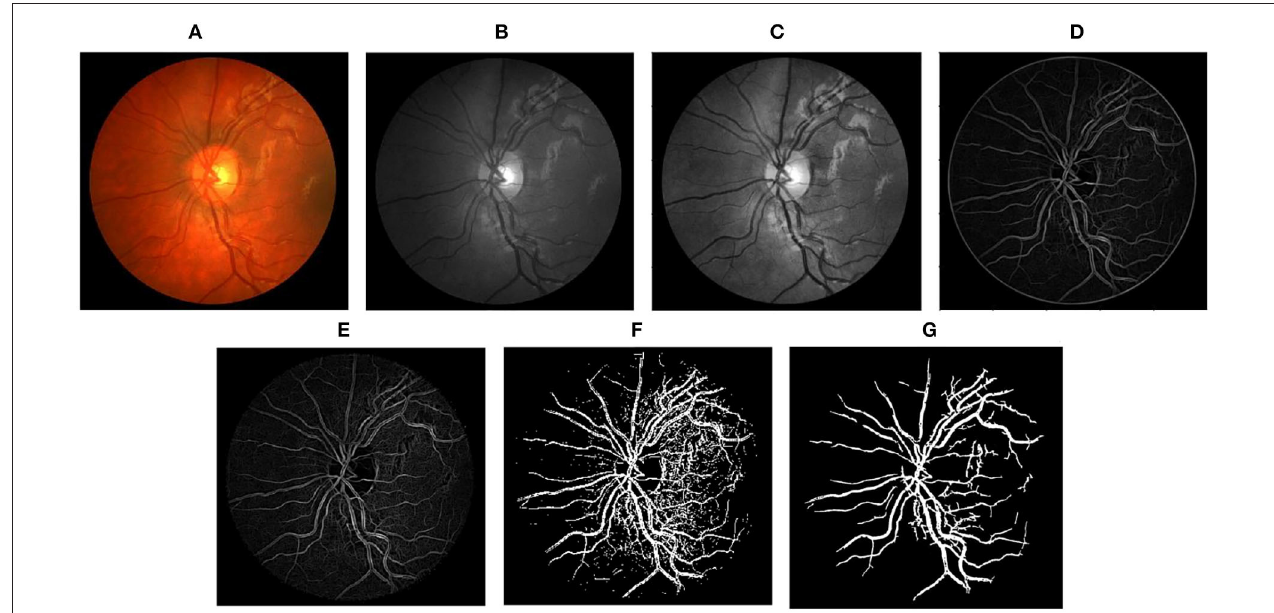
FIGURE 5 | Stepwise illustration of the proposed method. (A) Color retinal fundus image from CHASEDB1 database. (B) Green channel retinal fundus image. (C) Processing diagram after CLAHE. (D) Processing diagram after B-COSFIRE filters. (E) Processing diagram after morphological filters. (F) Processing diagram after binary threshold. (G) Final segmented image.